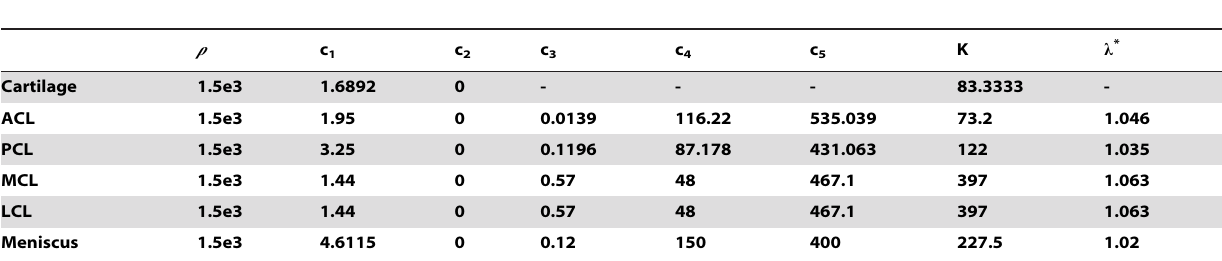
Table 1. Material parameters for articular cartilage [30], ligaments [31–33], and meniscus [34–46].